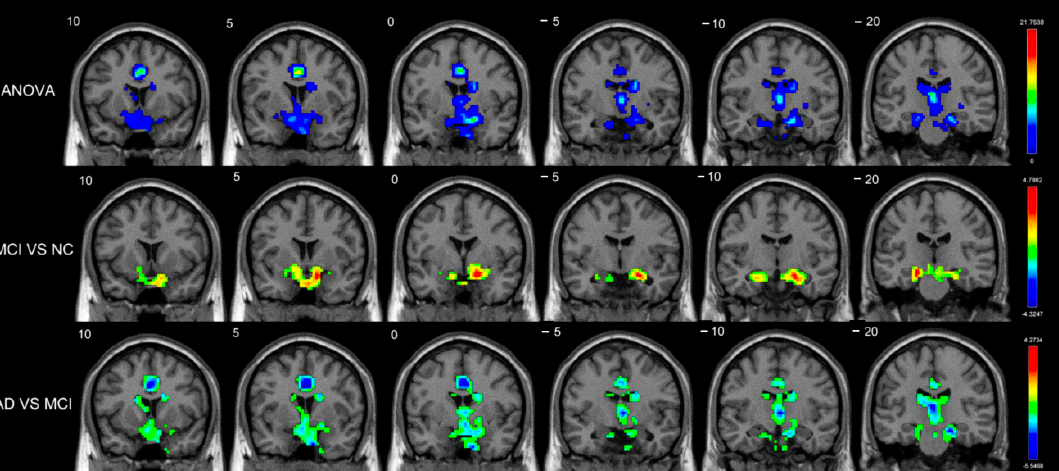
Figure 2. Brain regions with significant differences in long ‐ range FCDs (voxel ‐ level p < 0.01, cluster ‐ level p < 0.05, GRF ‐ corrected) among the AD, MCI, and NC groups. There were significant among ‐ group differences of long ‐ range FCDs in the bilateral caudate, the right amygdala, the right pallidum, and the right putamen. Increased long ‐ range FCDs in patients with MCI compared with normal controls were located in the bilateral amygdala, the left putamen, and the right pallidum. Decreased long ‐ range FCDs in patients with AD compared with patients with MCI were located in the bilateral caudate, the right amygdala, and the right pallidum.